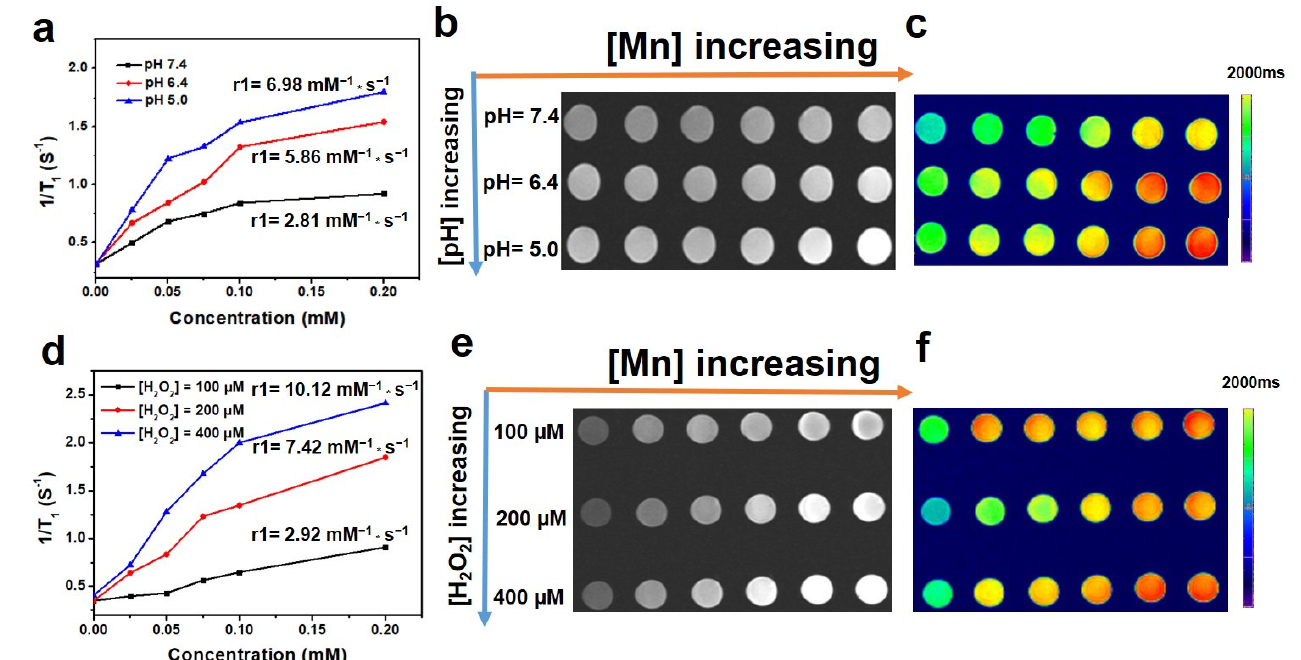
Figure 3. MRI performance of the EMT nanozyme in vitro. ( a ) Value of r1 at various pH values (5.0, 6.4, and 7.4) with different Mn concentrations. ( b ) MR images and ( c ) color trend chart of the EMT nanozyme in PBS at varied pH values (5.0, 6.4, and 7.4) with different Mn concentrations and without H 2 O 2 . ( d ) Value of r1 of the EMT nanozyme in PBS with various H 2 O 2 concentrations (100 µM, 200 µM, and 400 µM) at pH = 6.4. ( e ) MR images and ( f ) color trend chart of the EMT nanozyme in PBS with various H 2 O 2 concentrations (100 µM, 200 µM, and 400 µM) at pH = 6.4.